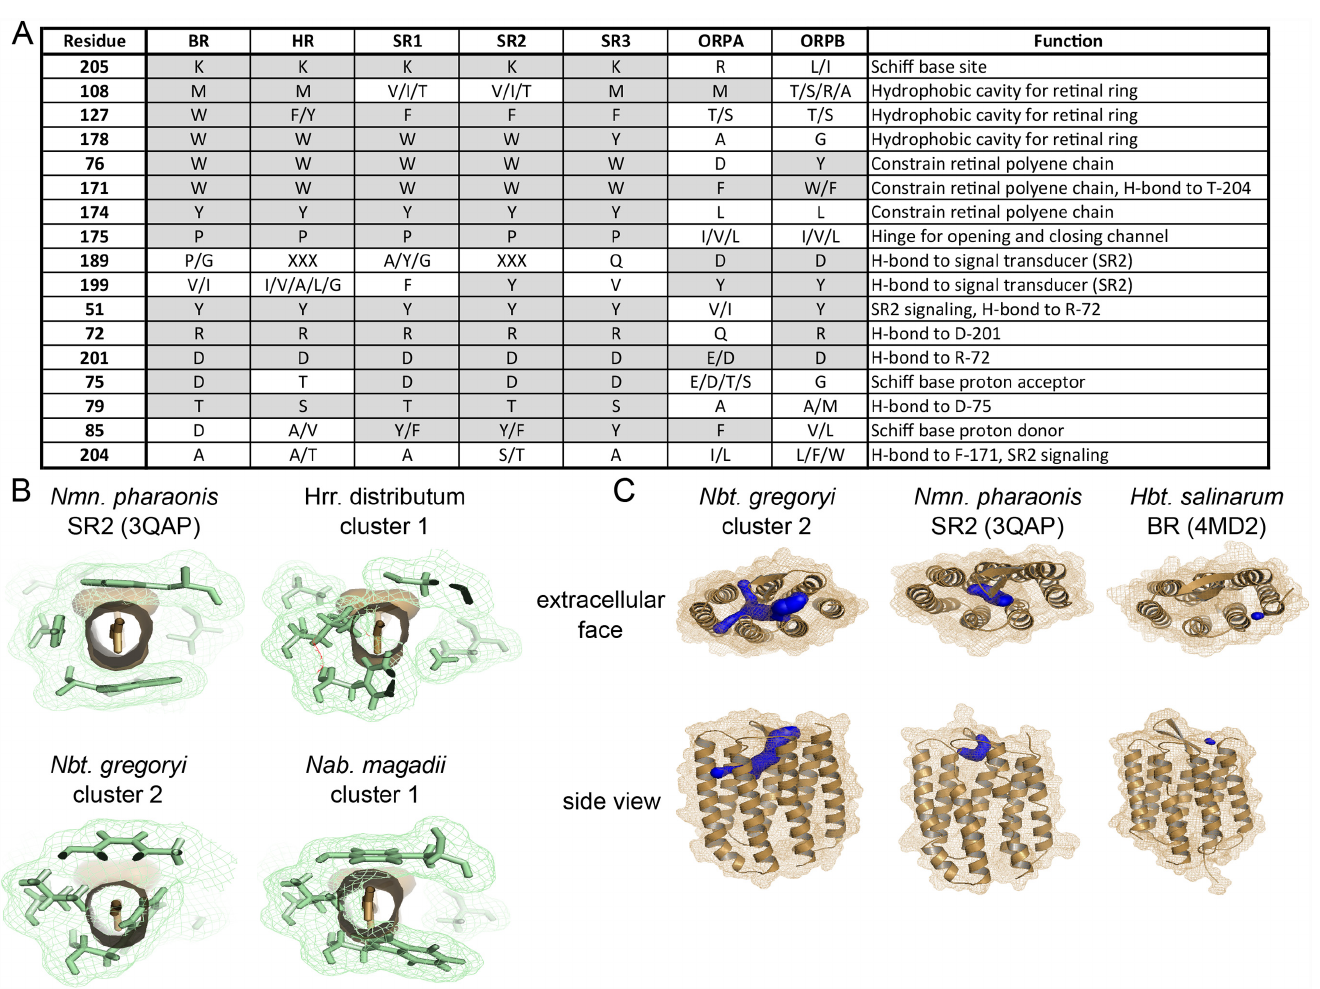
Fig 3. Residues important for signal propagation, but not retinal binding, are conserved across haloarchaeal ORP homologs. A. Conservation patterns in positions of functional importance across five canonical opsin and two ORP subclasses show that residues involved in signaling, but not those involved in retinal binding, are conserved in ORPs. XXX = highly variable. Positions with conserved or biochemically similar amino acid residue across multiple opsin classes are shaded. Residue numbering is according to Natronomonas pharaonis SRII (YP_331142). B. Residues forming the retinal binding cavity in canonical opsins show steric clash with canonical retinal binding pocket in predicted ORP structural models. Residues corresponding to Natronomonas pharaonis SRII V108, F127, W178, W76, W171, and Y174 are shown in green with lattice representing atomic surface. Retinal is shown in tan, looking down polyene chain, with solid tan representing atomic surface. C. Representative output visualizations from CAVER [58] showing predicted novel extracellularly accessible binding pocket and internal tunnel network for Nbt . gregoryi WP_005575895. Similar search parameters revealed much smaller (SRII, BR) or no (HR) cavities for canonical opsins. For all CAVER predictions, see S2